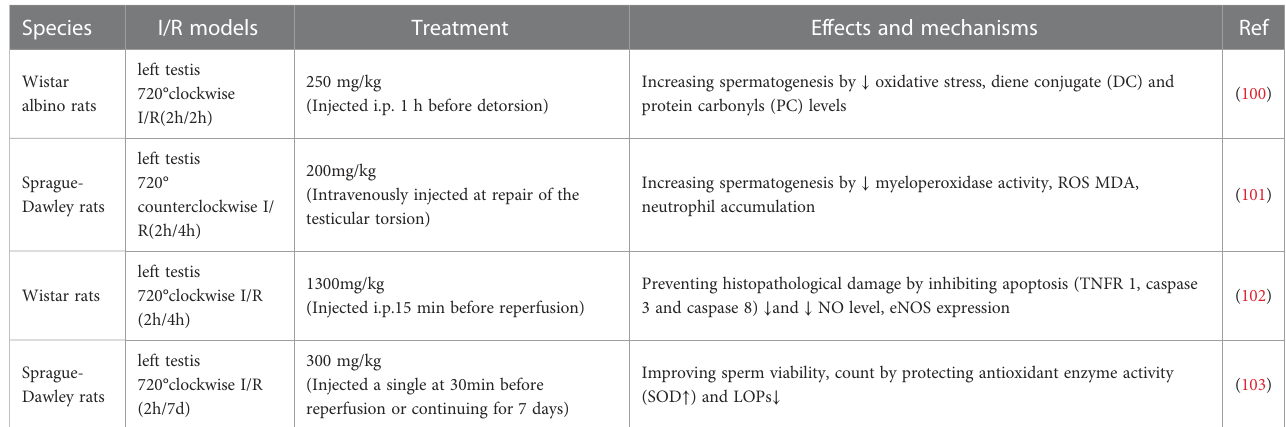
TABLE 2 Protective effects of taurine on testicular I/R